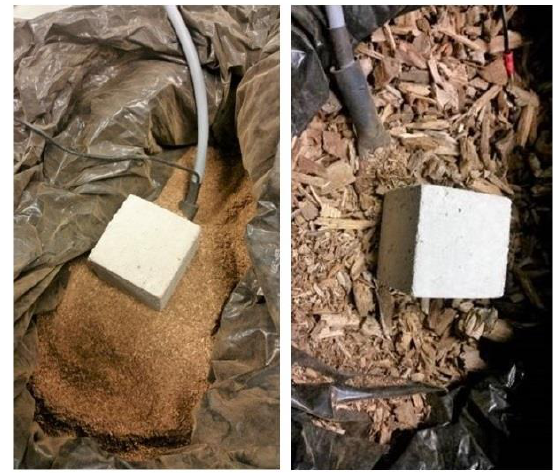
Figure 7. Probe positioning (U-series samples).